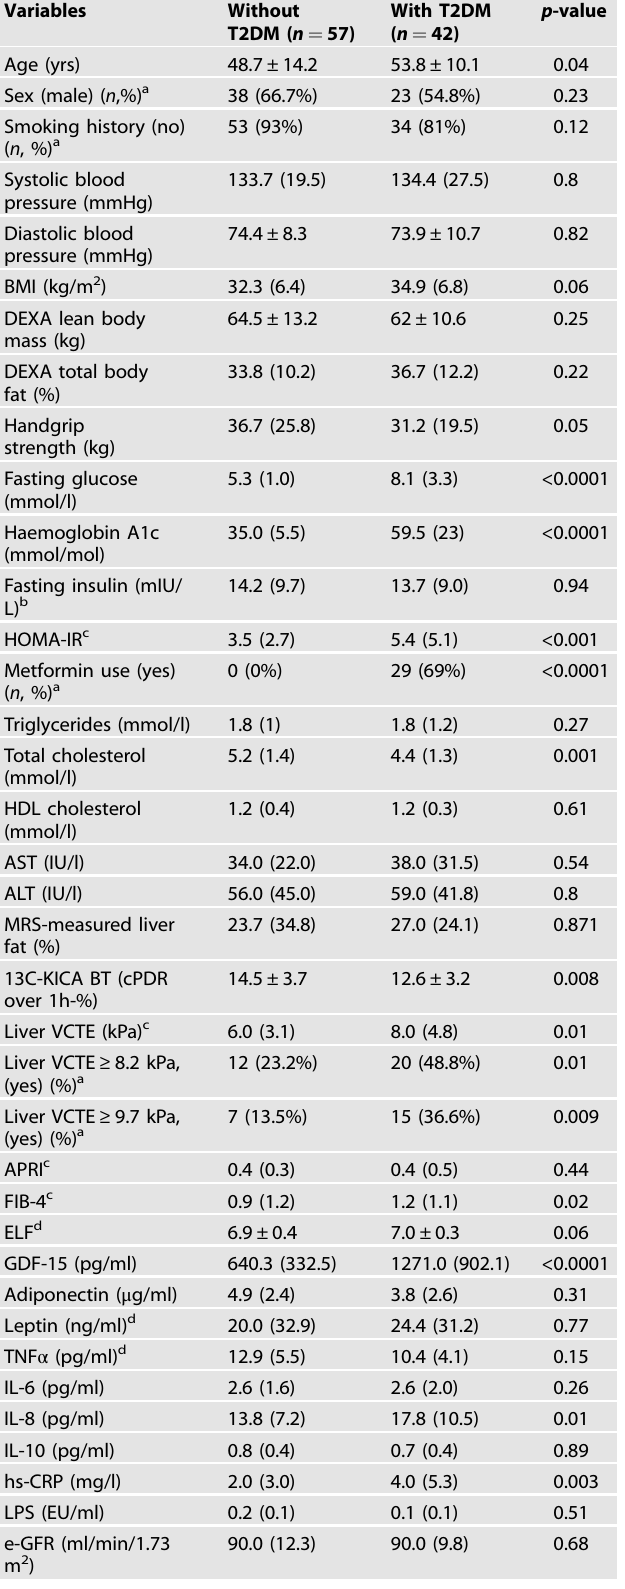
Table 1. Characteristics of patients with NAFLD strati fi ed by pre- existing type 2 diabetes